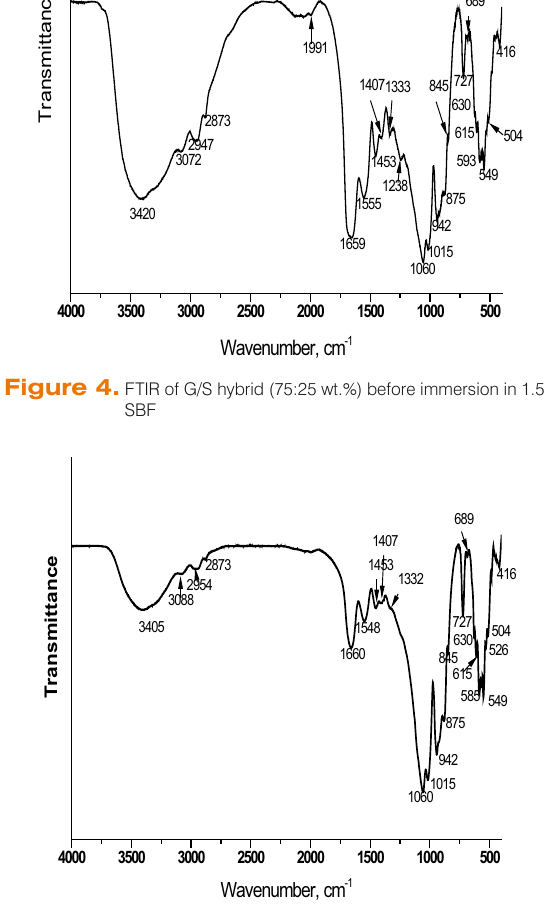
Figure 5. FTIR of G/S hybrid (25:75 wt.%) before immersion in 1.5 SBF